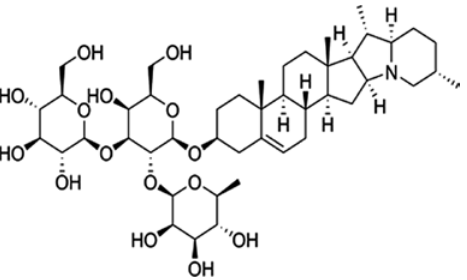
Figure 3: Saponin chemical structure.